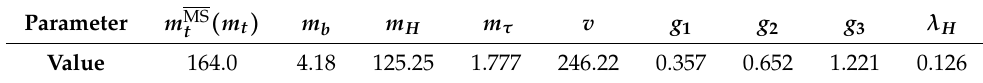
Table 3. Used SM inputs in our analysis, at µ = m Z = 91.18 GeV, with the exception of top mass, which is evaluated at µ = m t . Masses and vacuum expectation values are in GeV units [3].